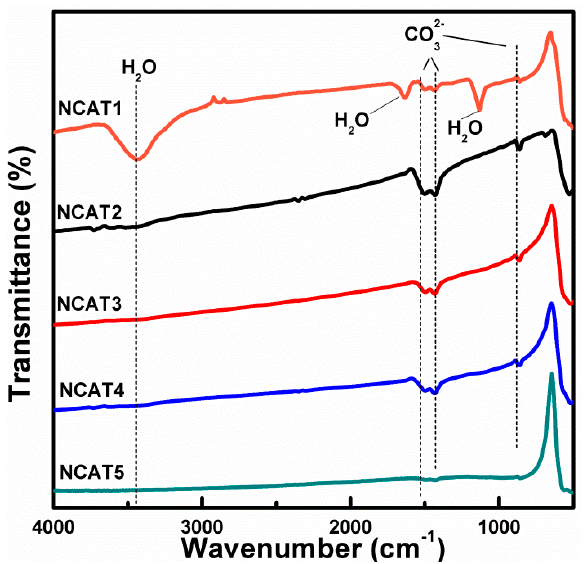
Figure 4. FTIR spectra of NCA particles heated at various temperatures.